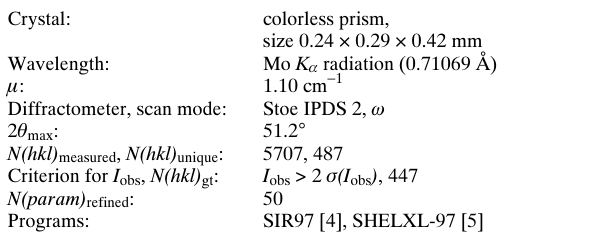
Table 1. Data collection and handling.